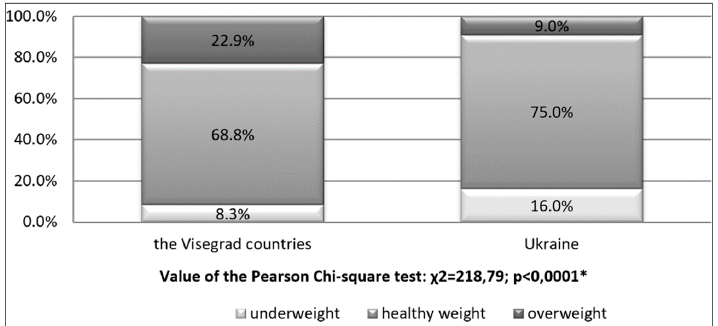
Figure 1. BMI classification in various countries. * Significant variation at p < 0.05.